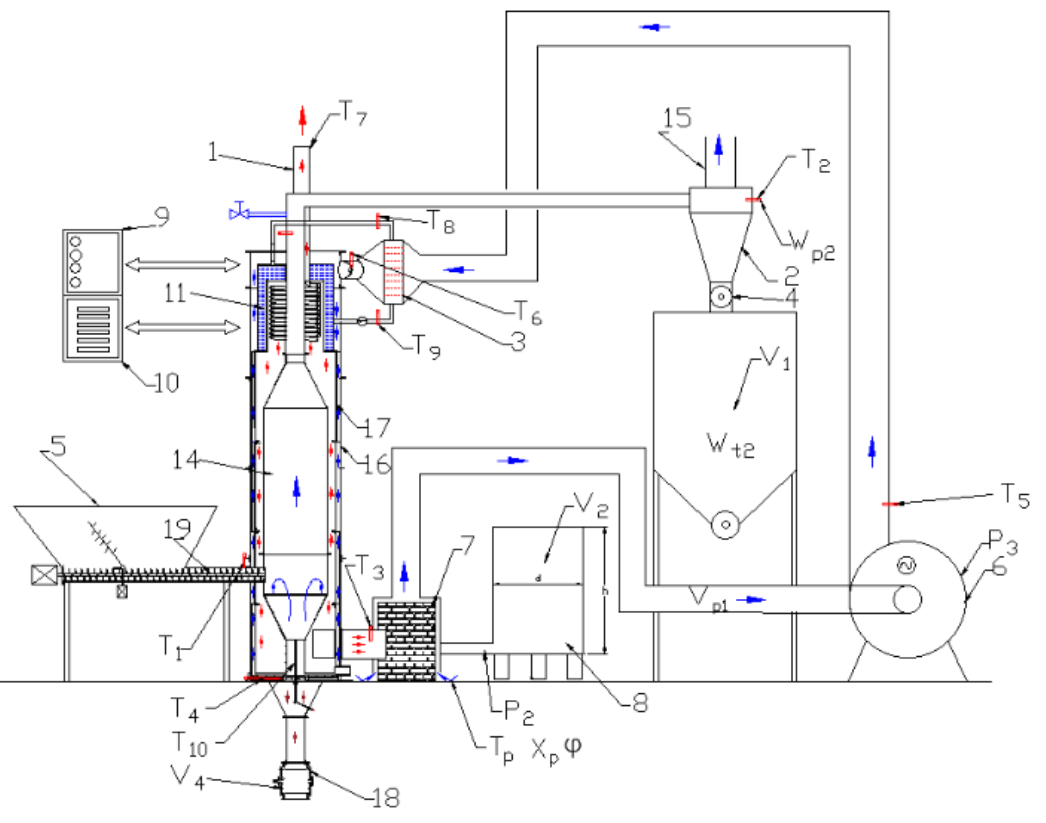
Figure 1. Schematic view of the dryer with marked measurement places: 1: moist air outlet; 2: cy-